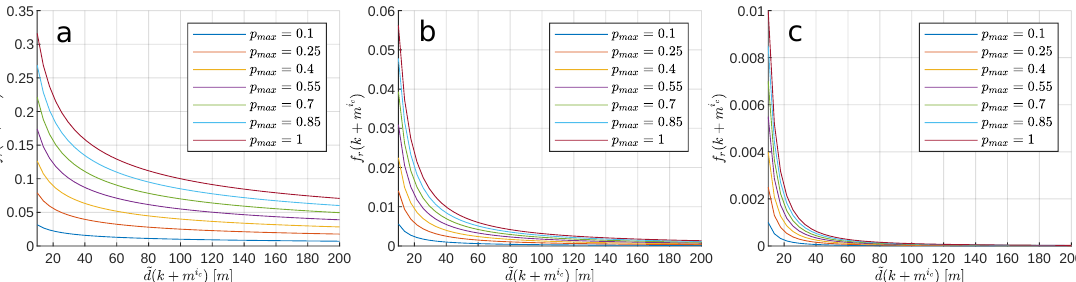
Figure 10. Repulsive forces as a function of possible future distance, maximum probability of occupancy and different values of n d ; ( a ) n d = 0.5, ( b ) n d = 1.25 and ( c ) n d =